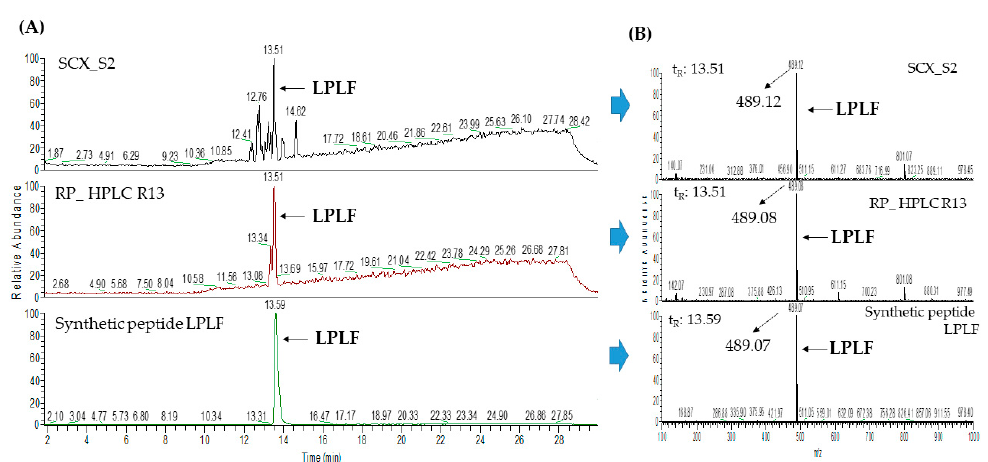
Figure A4. ( A ) LC–MS chromatograms of SCX S2, RP R13, and the synthetic peptide LPLF, ( B ) MS spectra of LPLF originated from fraction SCX S2 ( m / z 489.12, t R 13.51 min), fraction RP R13 ( m / z 489.08, t R 13.51) and synthetic LPLF ( m / z 489.07, t R 13.59).